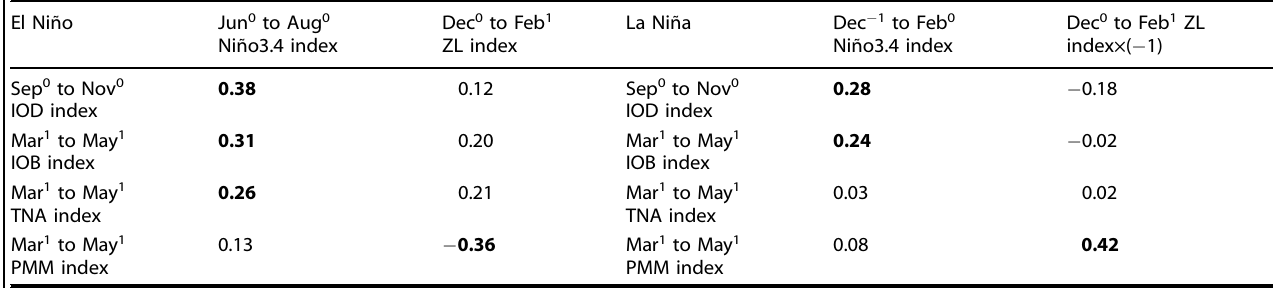
Values in bold indicate that the coef fi cients are statistically signi fi cant at 99.9% con fi dence level based on the Student ’ s t test. The ZL index for La Niña is multiplied by − 1, so that an increasing (decreasing) index value indicates more eastward (westward)-centered La Niña